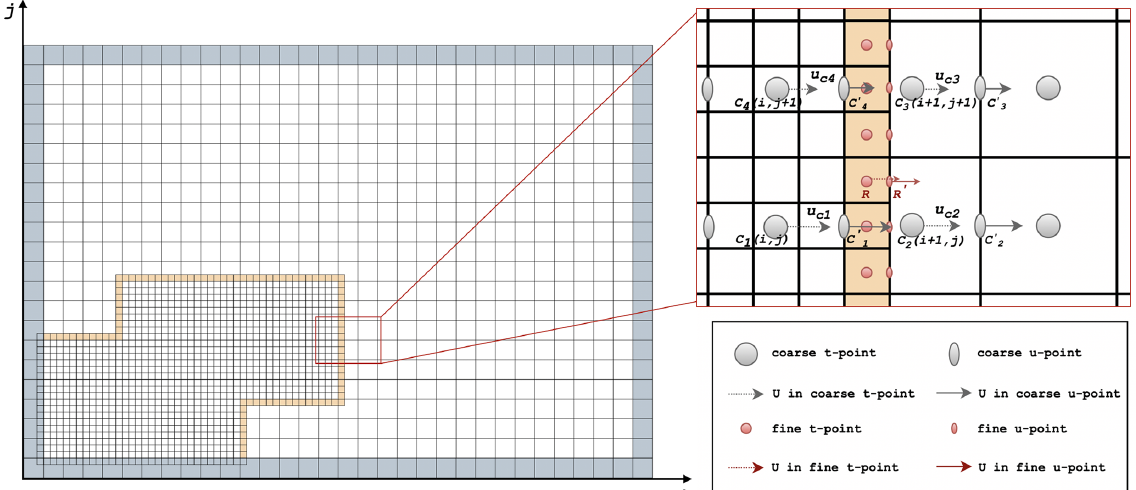
Figure 4. Example of a refinement region with an irregular boundary (refinement ratio 1 : 3) with the idealized test case in Sect. 3. The size of the coarse grid for the modeled ocean basin is 30 × 20. Physical boundaries are marked by grey cells. The inter-level halo, marked by yellow cells, is controlled by the coarse level but on the same resolution as the fine level. A specific region on the coarse level-fine level boundary is shown on the right, with details of the variable layout ( u and t